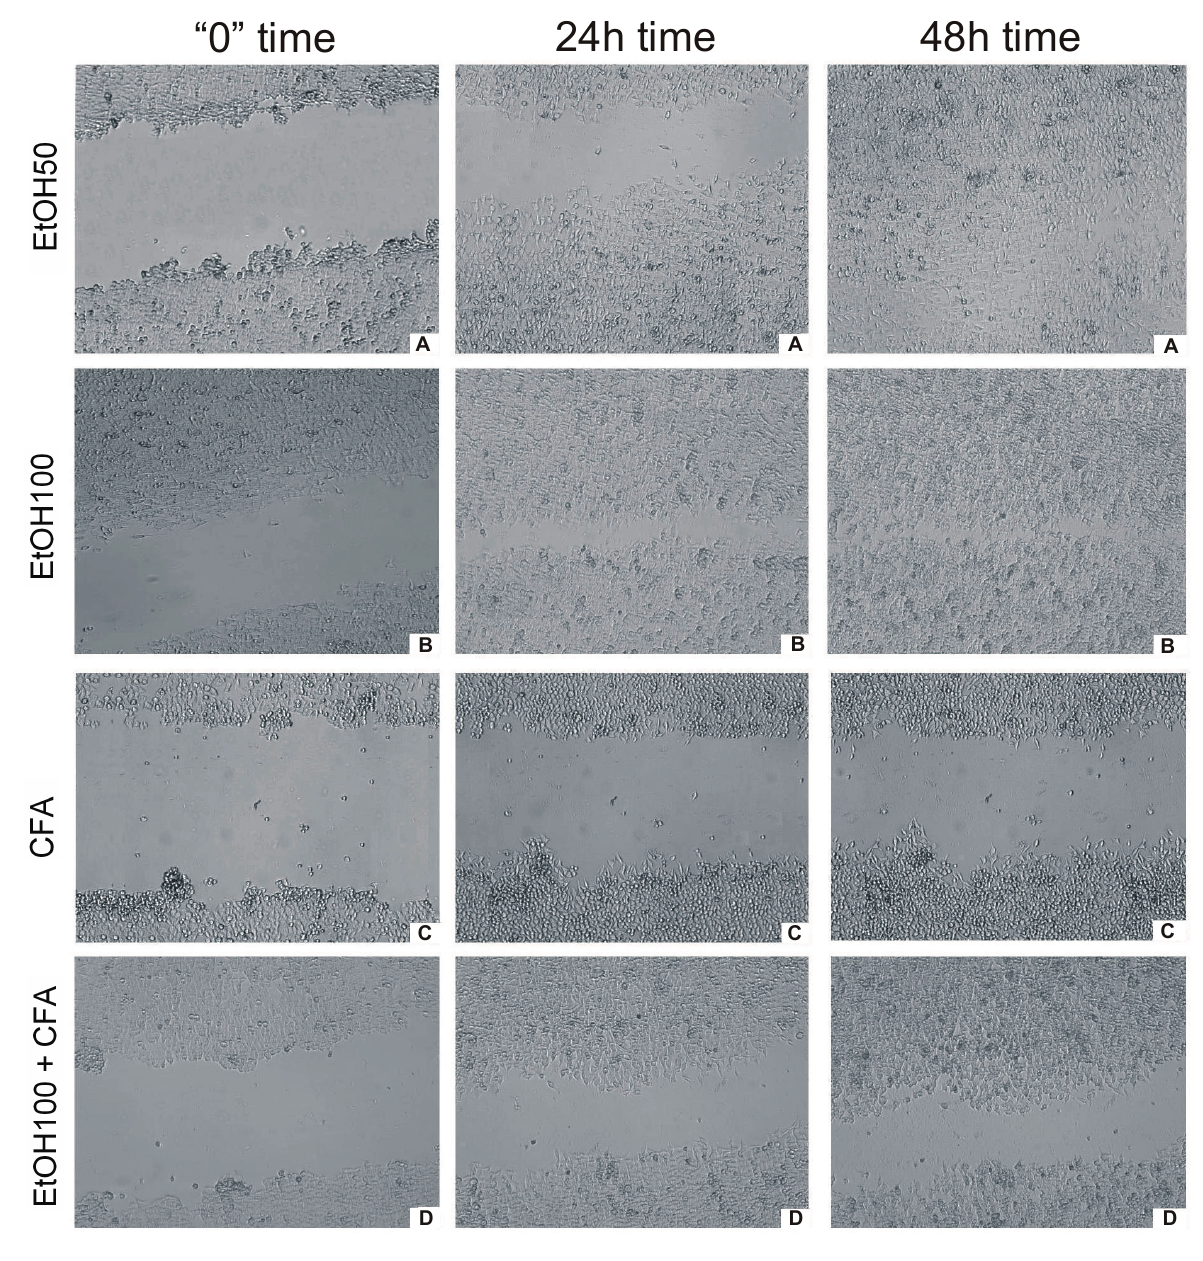
Figure 5. Time-dependent effect of CFA, EtOH and combination of CFA + EtOH on oral carcinoma cells’ migration representing by “wound” closure assay. Images of “wound” closure and migration rate of SCC-25 cells at different time points taken with JuLi FL. ( A ) effect of CFA at three different time points; ( B ) effect of EtOH + CFA at three different time points; ( C ) effect of EtOH50 + CFA at three different time points; ( D ) effect of EtO100 + CFA at three different time points. ( Left column) cells at start of experiment; ( middle column) cells after 24 h of experiment; ( right column) cells at the end of “healing wound” experiment 48